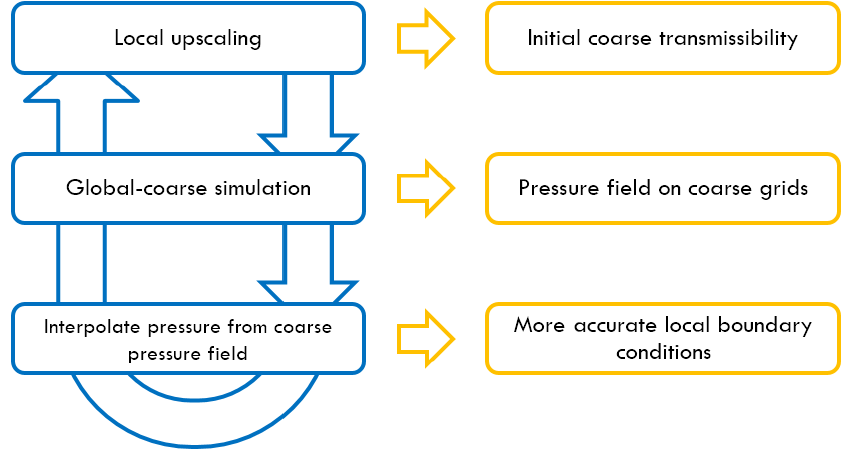
Figure 1. Workflow of local-global upscaling